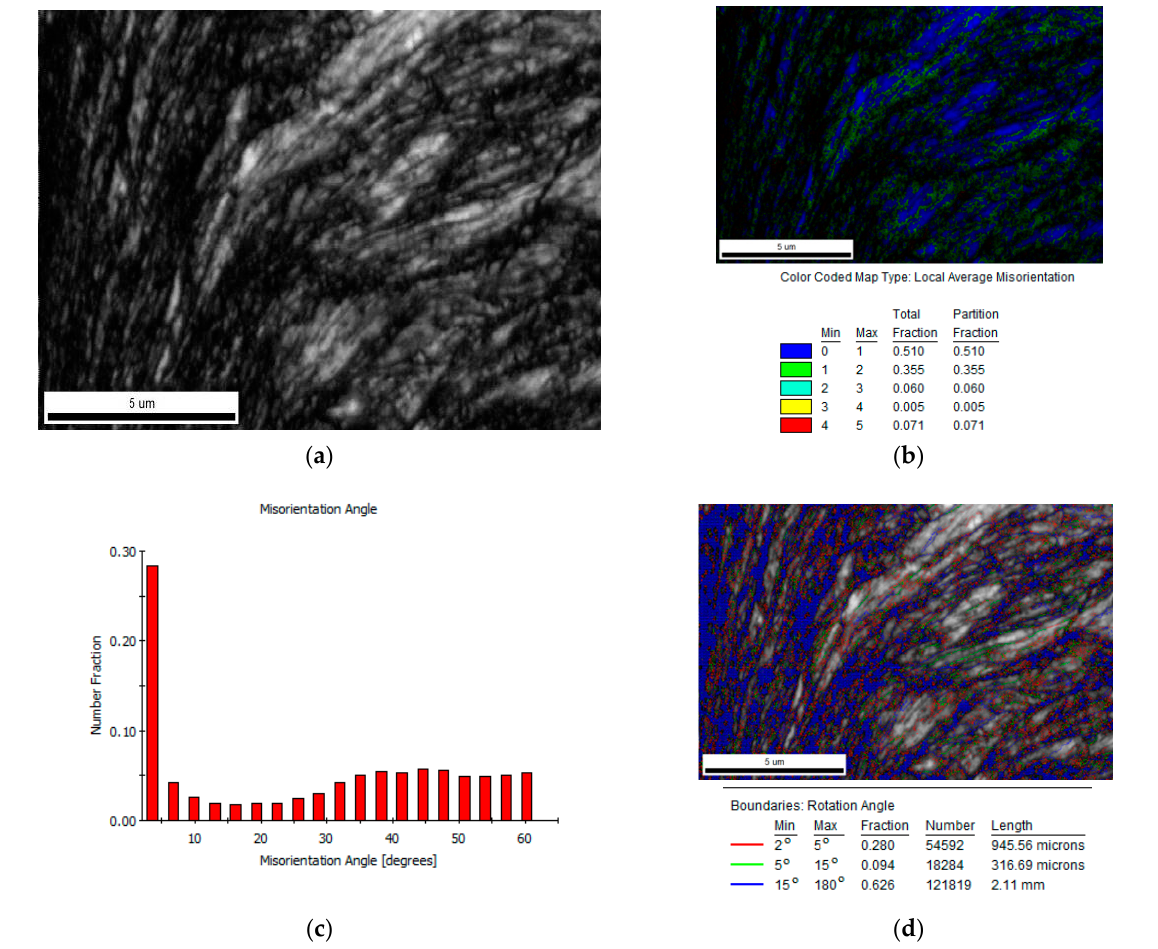
Figure 6. Orientation diagram of deformed zone of blanked edge (SPM 600). ( a ) Image quality (IQ) map; ( b ) Local average misorientation (LAM); ( c ) Misorientation angle distributions; ( d ) Grain boundaries map.